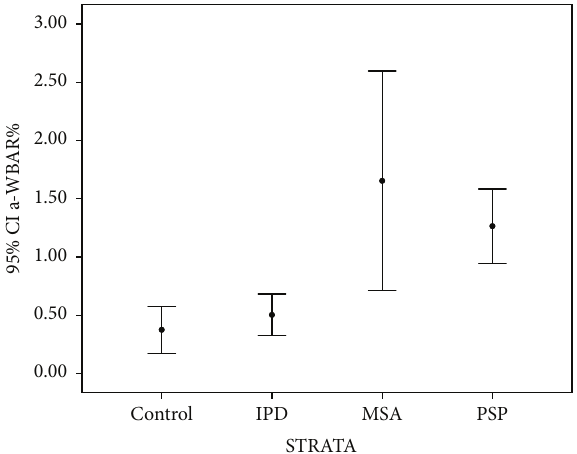
Figure 2: Error bars showing 95% confident intervals of a-WBAR means for each